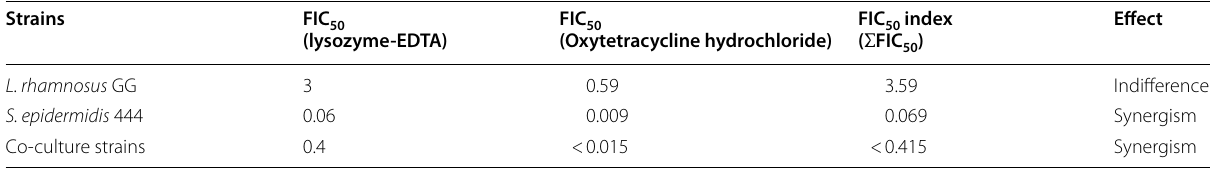
for combinations of lysozyme-EDTA and oxytetracycline hydrochloride at pH 7.5 against planktonic